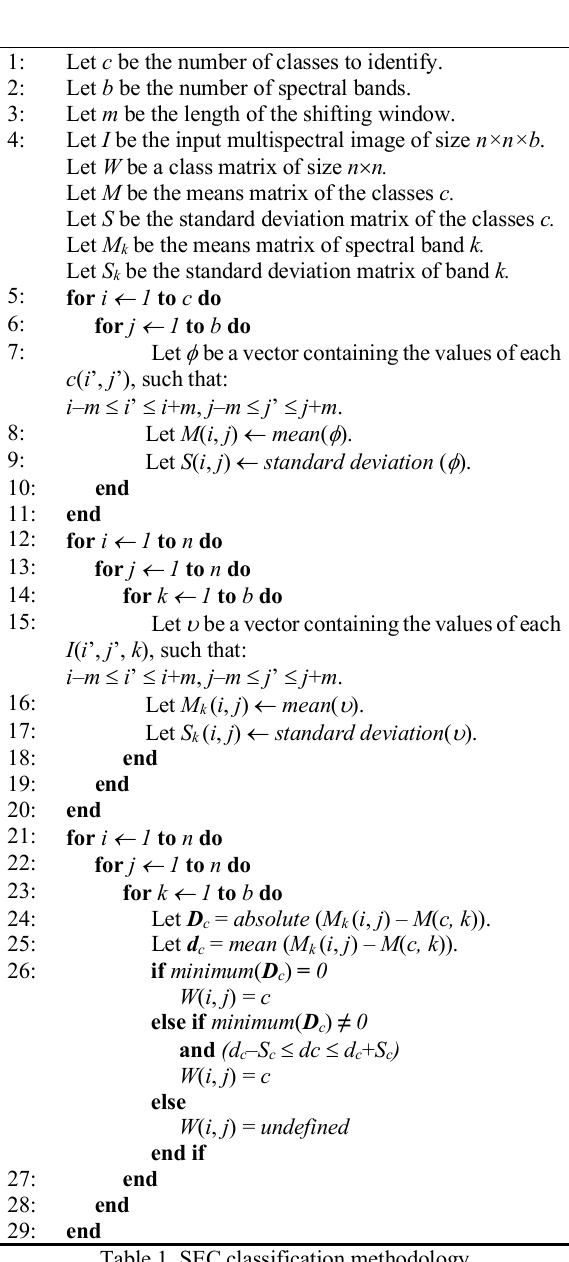
Table 1. SEC classification